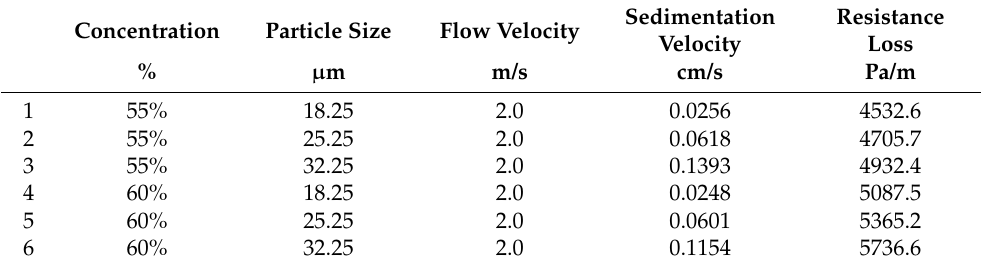
Table 11. Case analysis